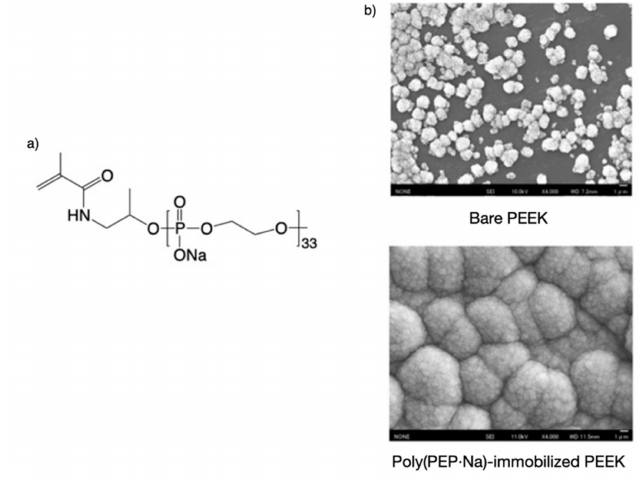
Figure 4. ( a ) Chemical structure of the polyphosphodiester PEP · Na macromonomer and ( b ) scanning electron micrographs of poly(ether ether ketone) (PEEK) and poly(PEP · Na)-immobilized